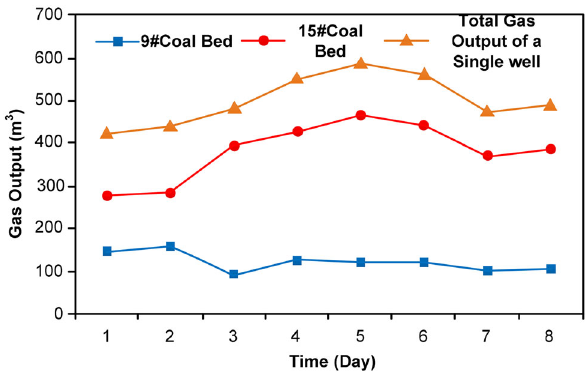
Fig. 9 Gas outputs from different